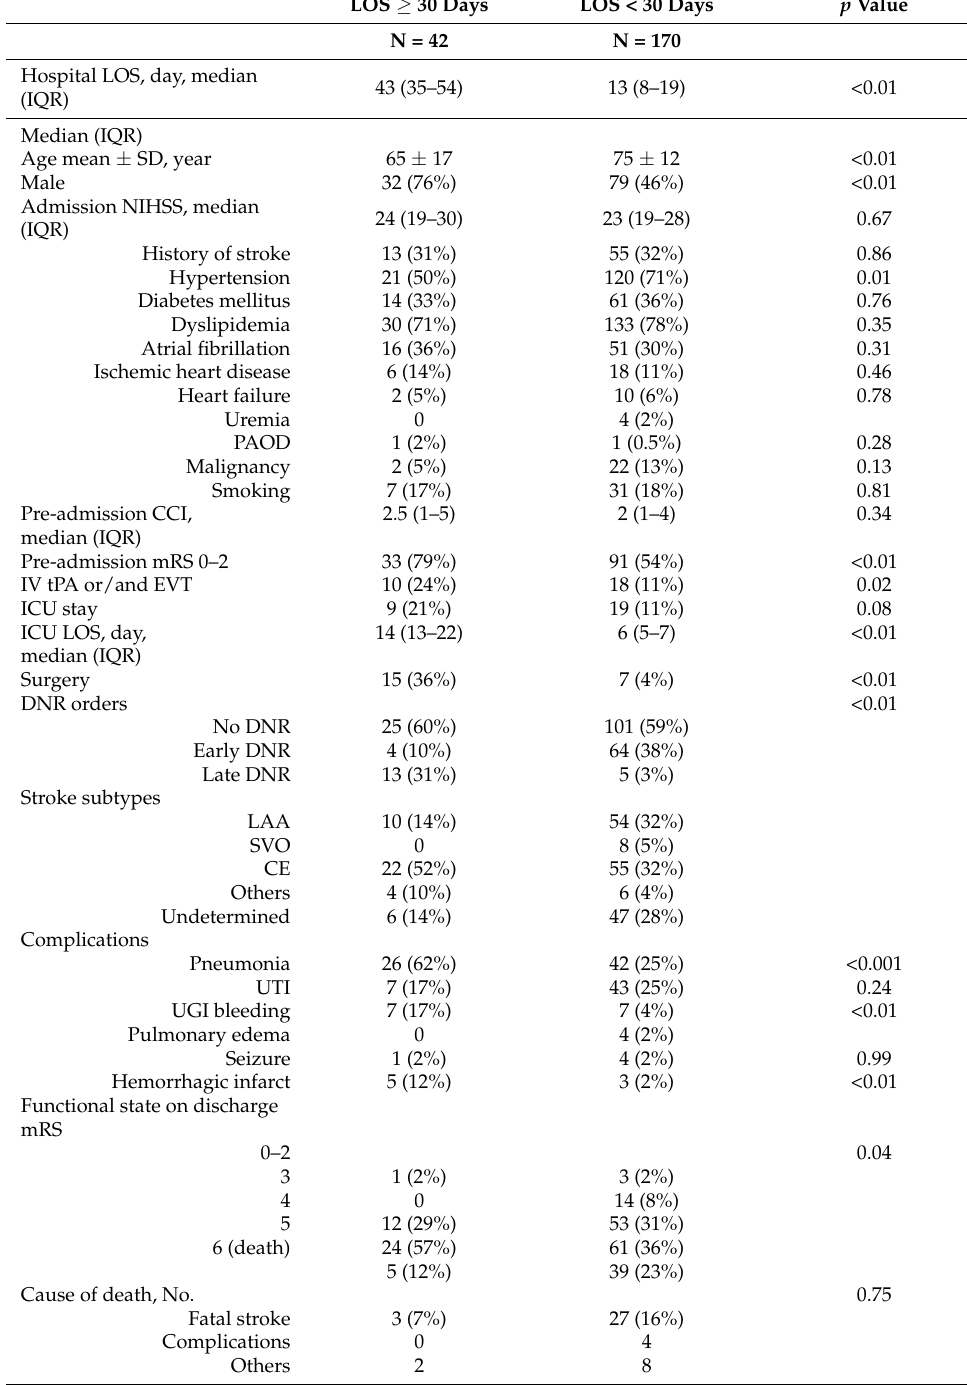
Table 1. Demographic data and clinical characteristics * in 212 patients with severe acute ischemic stroke classified by